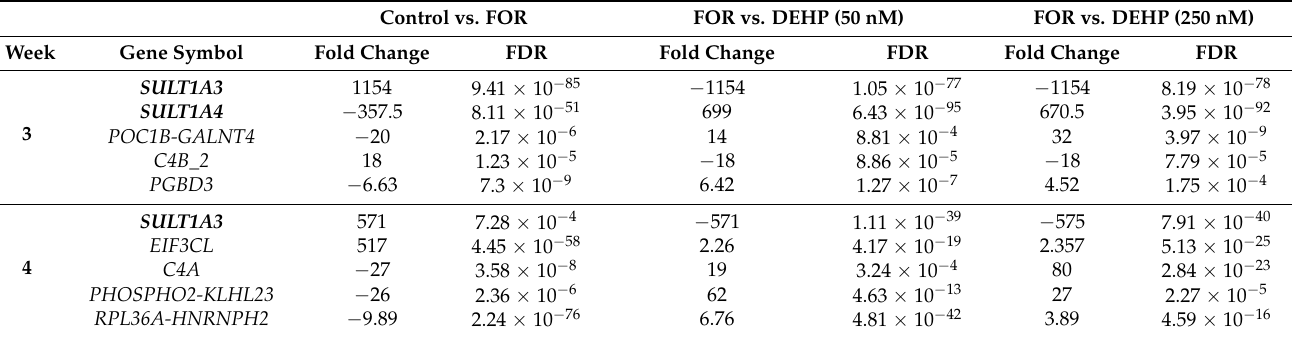
Table 3. Cont. Control vs. FOR FOR vs. DEHP (50 nM) FOR vs. DEHP (250 nM)